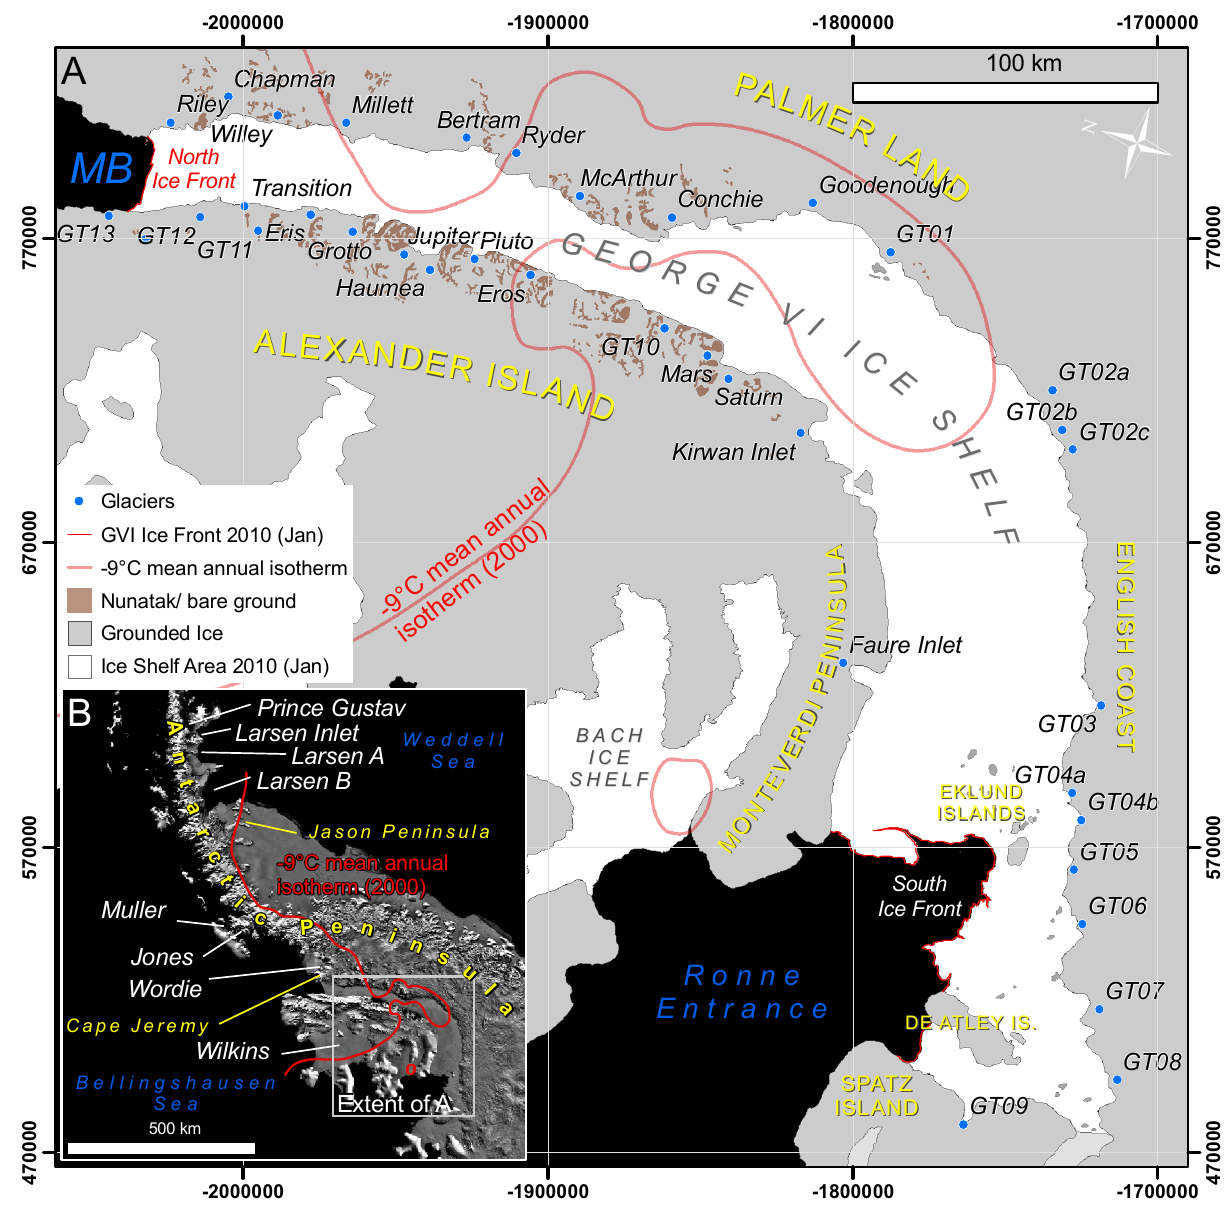
Fig. 1. (A) George VI Ice Shelf with localities mentioned in the text and its key tributary glaciers. The names of tributary glaciers were taken from the Antarctic Place-names Committee (http://www.antarctica.ac.uk/apc/) except for those labelled “GT##” that were otherwise previously unnamed. Note the positioning of the − 9°C mean annual isotherm across Alexander Island (source: Morris and Vaughan, 2003). MB = Marguerite Bay. (B) The Antarctic Peninsula region displaying localities mentioned in the text, including the embayments of former ice